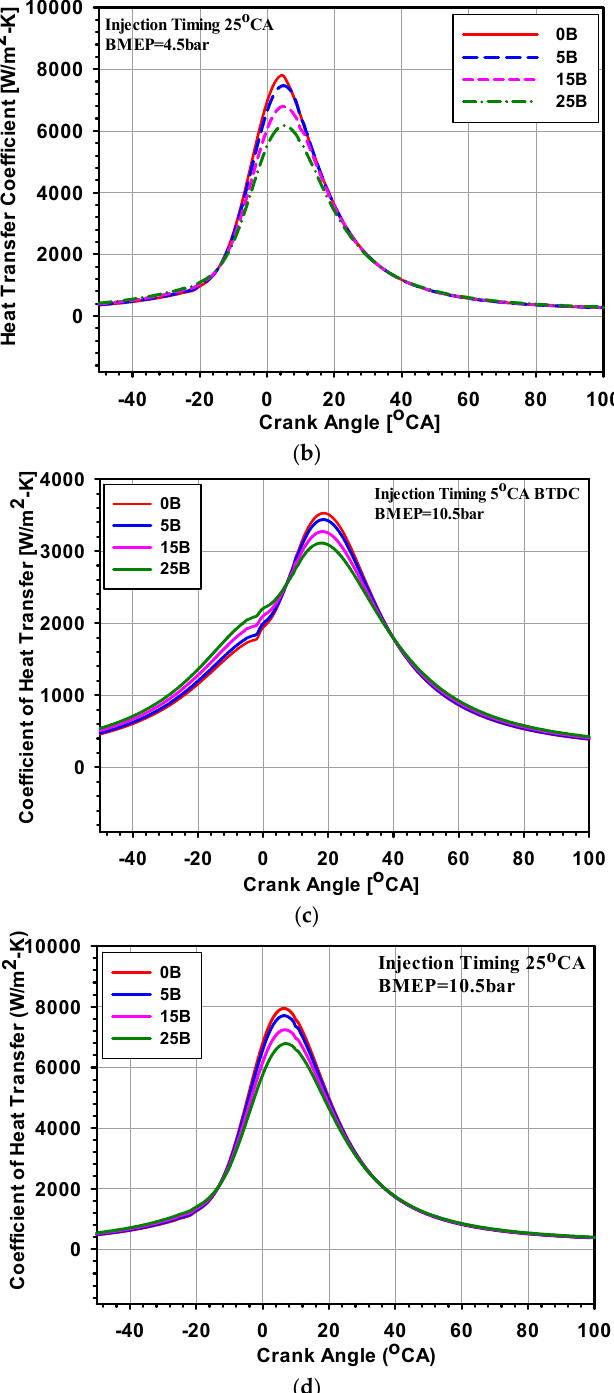
Figure 14. Variation of coefficient of heat transfer: ( a ) BMEP 4.5 bar, injection timing 5 ° CA bTDC; ( b ) BMEP 4.5 bar, injection timing 25 ° CA bTDC; ( c ) BMEP 10.5 bar, injection timing 5 ° CA bTDC; and ( d ) BMEP 10.5 bar, injection timing 25 ° CA bTDC.